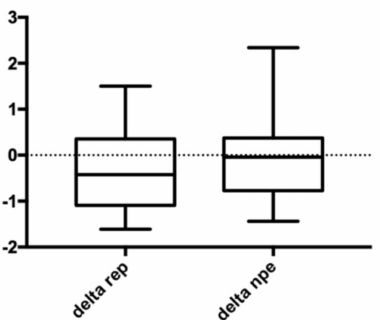
Figure 6. Palatal height. Delta REP is the variation in patients treated with RPE; Delta NPE-2 is the variation in patients treated with NPE-2; the numbers show the variation measured in millimeters.